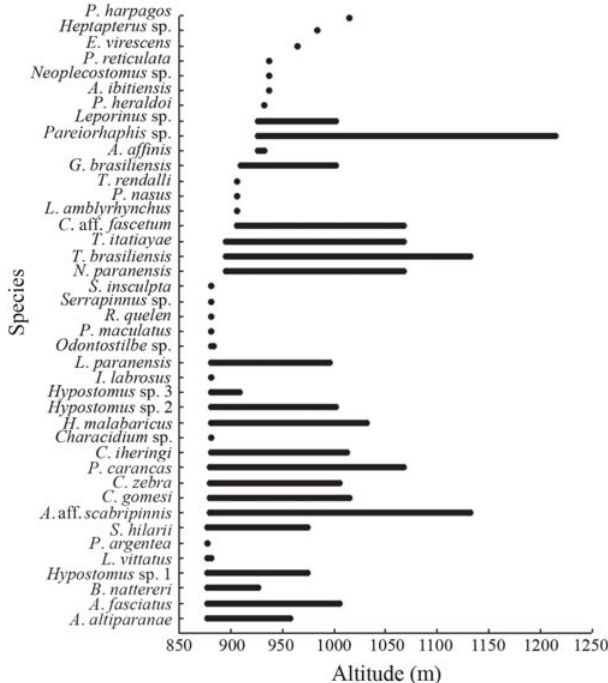
Fig. 4. Altitudinal distribution of sampled species in the region of upper rio Capivari basin.